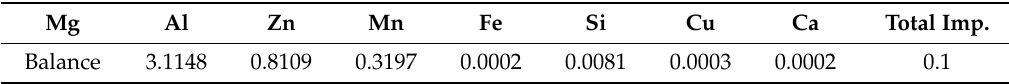
Table 1. AZ31B chemical compositions (wt. %).